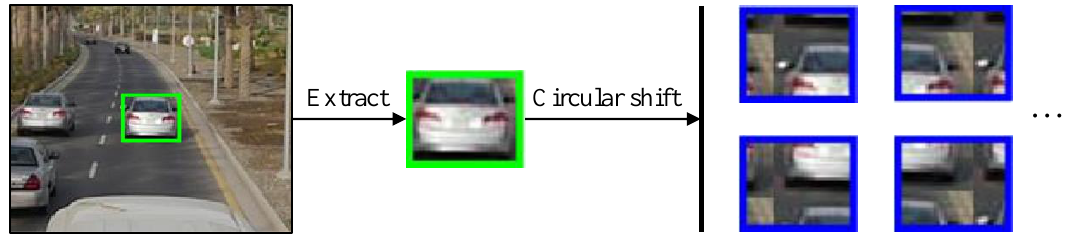
Figure 2. Tracker with classical correlation filter (CF) is trained with synthetic negative